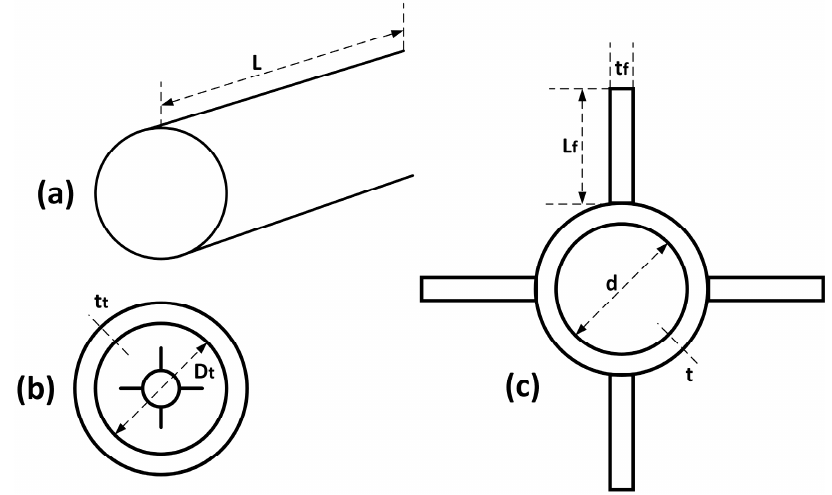
Figure 2. Single-tube MH material heat transfer-coupled system, showing: ( a ) Simplified external view of a single MH tube; ( b ) 2D frontal view of the single tube with a four-fin internal minichannel heat transfer tube; ( c ) zoomed view of the internal finned minichannel heat transfer fluid tube. L is the length of the tube, D t is the diameter of the MH tube, t t is the thickness of the MH tube, d is the diameter of the heat transfer fluid tube, t is the thickness of the heat transfer tube, L f is the height of the fin and t f is the thickness of the fin.